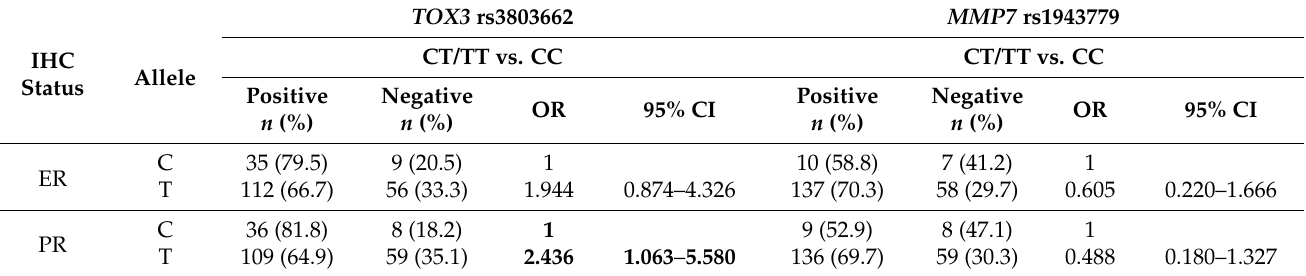
Table 5. Association of TOX3 and MMP7 polymorphisms with receptors’ expression and metastasis in BC